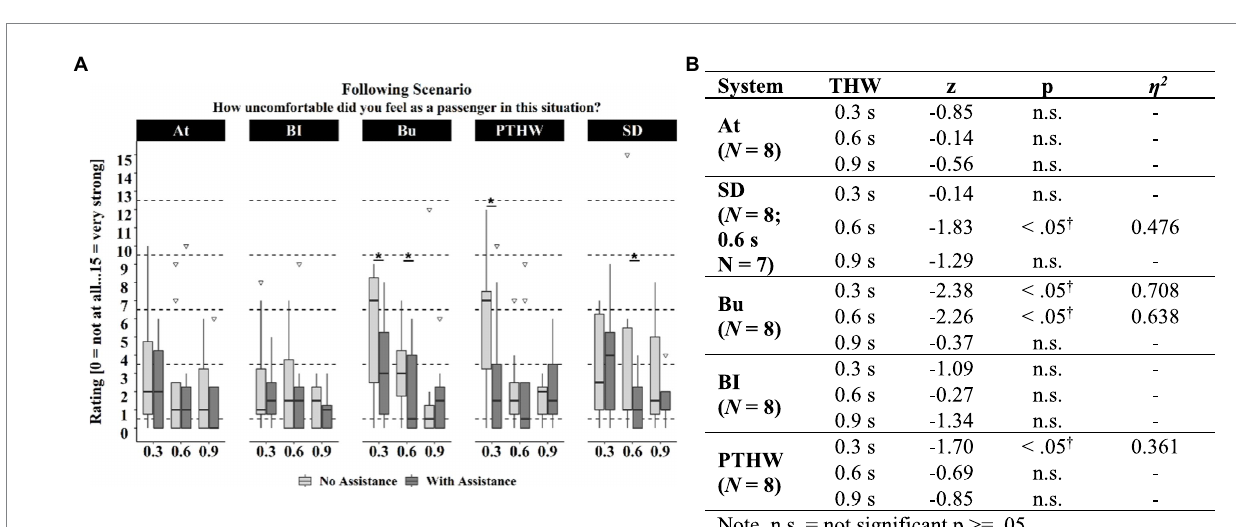
FIGURE 12 (A) Discomfort ratings experienced during the Following scenarios for each time headway with assistance system and without across assistance systems. Significant ( p < 0.05) differences between ratings with and without assistance system are marked with *. Box range = Q1 to Q 3. Whiskers = 1.5 * IQR. (B) Asymptotic Wilcoxon-Tests for discomfort differences during following scenarios between assisted and baseline rides by time headway and assistance